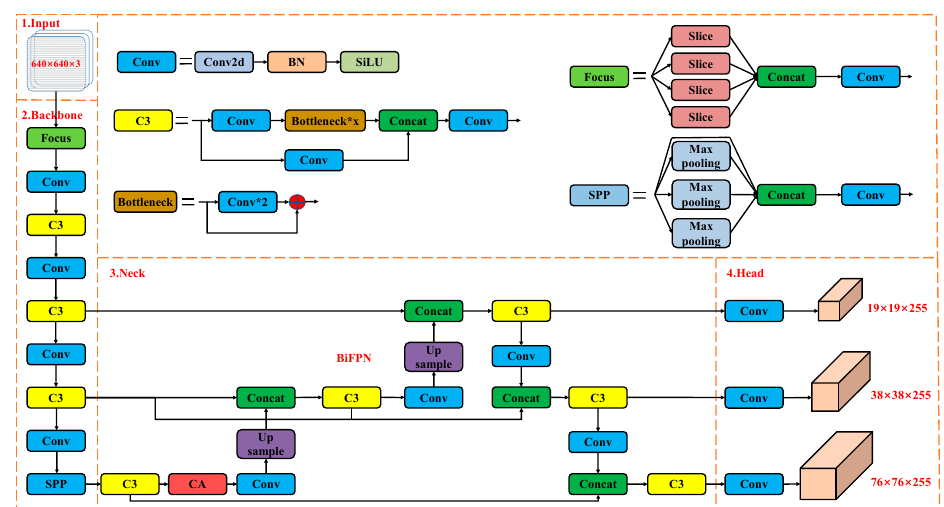
Figure 4. The YOLOv5_Tel model’s structure. The feature pyramid module is changed to the BiFPN network and the CA module is added to achieve better detection performance.